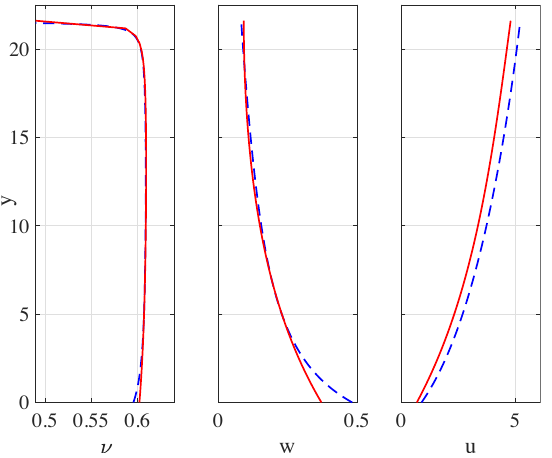
Fig. 2 Dimensionless flow height versus volume fraction, n , dimensionless fluctuation velocity, w, and mean velocity, u, for M = 13 and the parameter values of Fig. 1. The dashed curves are the numerical integrations of the differential equation; the solid curves are the approximate analytical